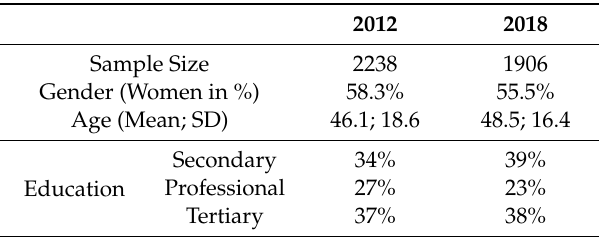
Table 2. Samples of the Georgian Christian orthodox population in 2012 and 2018. Descriptive statistic on number of participants, gender, age, and